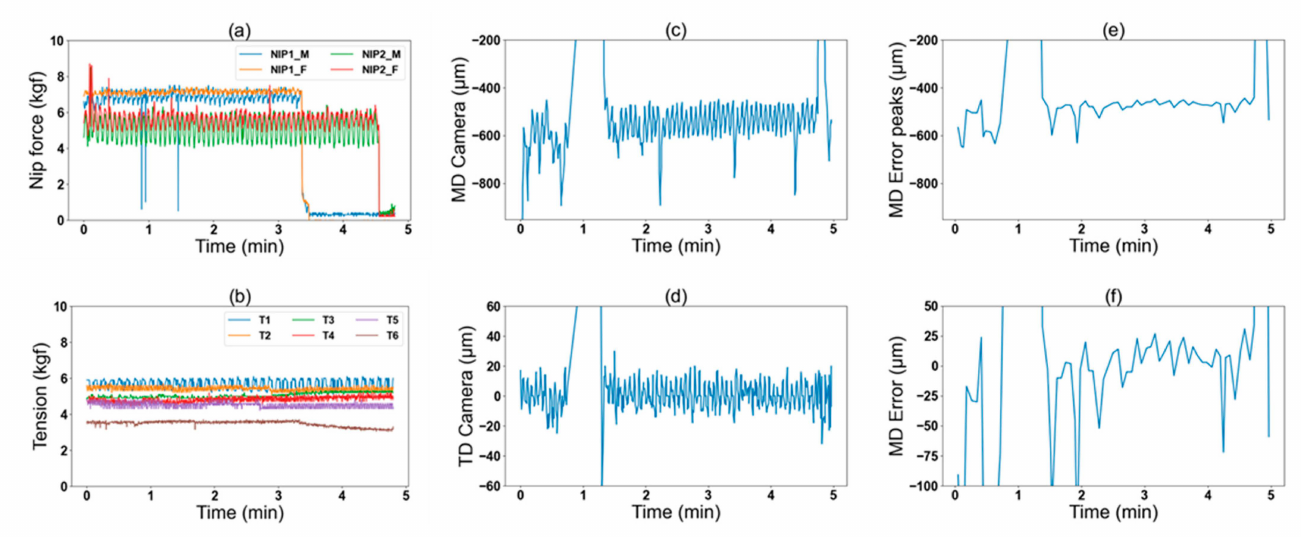
Figure 5. Raw data from the R2R gravure printing processes: ( a ) the nip force data from first and second printing units, ( b ) the web tension data from unwinder, first and second printing units, and out-feeder, ( c ) registration errors for MD, ( d ) registration errors for TD, ( e ) peak values from the camera data, obtained by computing the local minimums and maximums in MD registration errors (shown in ( c )), and ( f ) the MD error calculated by estimating an offset line around which the registration error peaks oscillate, and then subtracting the offset value from the peaks